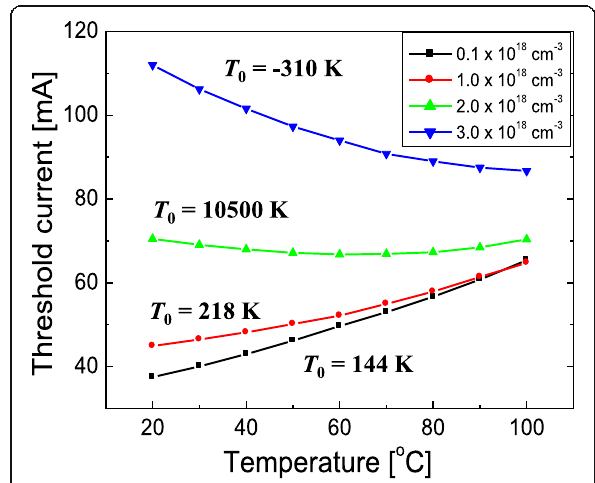
Fig. 4 Threshold current ( I th ) as a function of temperature for barrier doping concentrations of 0.1, 1, 2, and 3 × 10 18 cm − 3 . The T 0 value for each doping concentration is shown. Here, the barrier thickness is fixed at 10 nm